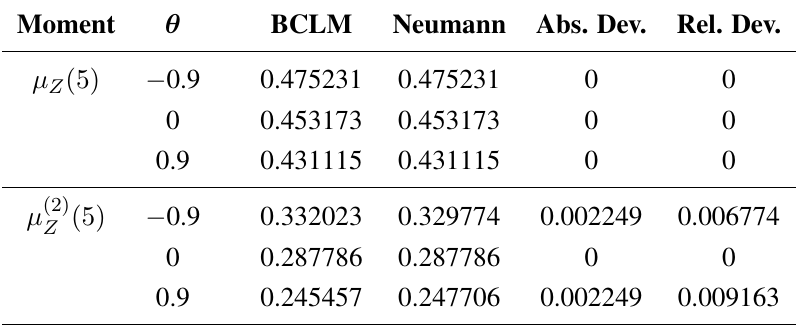
Table 1. Moment verification: the case of the FGM copula. Abs. Dev., absolute deviation; Rel. Dev., relative